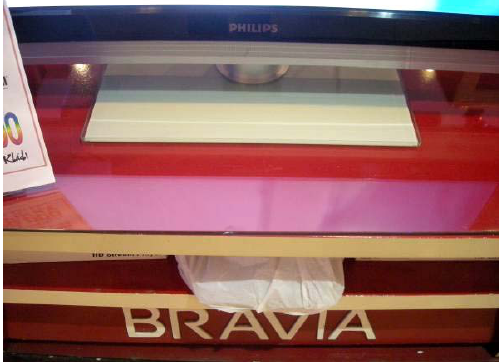
Figure 2. A Philips LCD TV on a Bravia